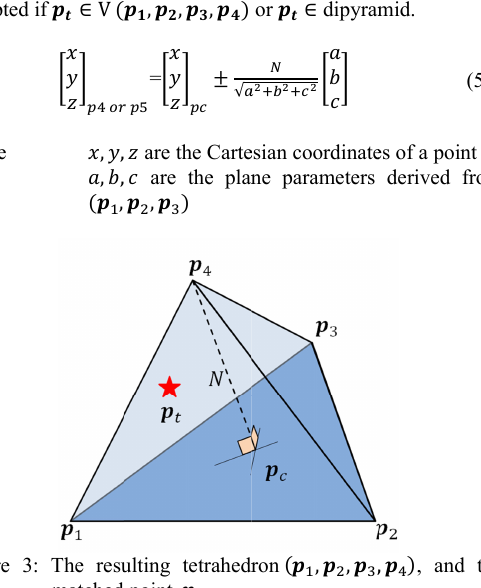
Figure 3 dem The set (cid:4666)(cid:2198) (cid:2202)